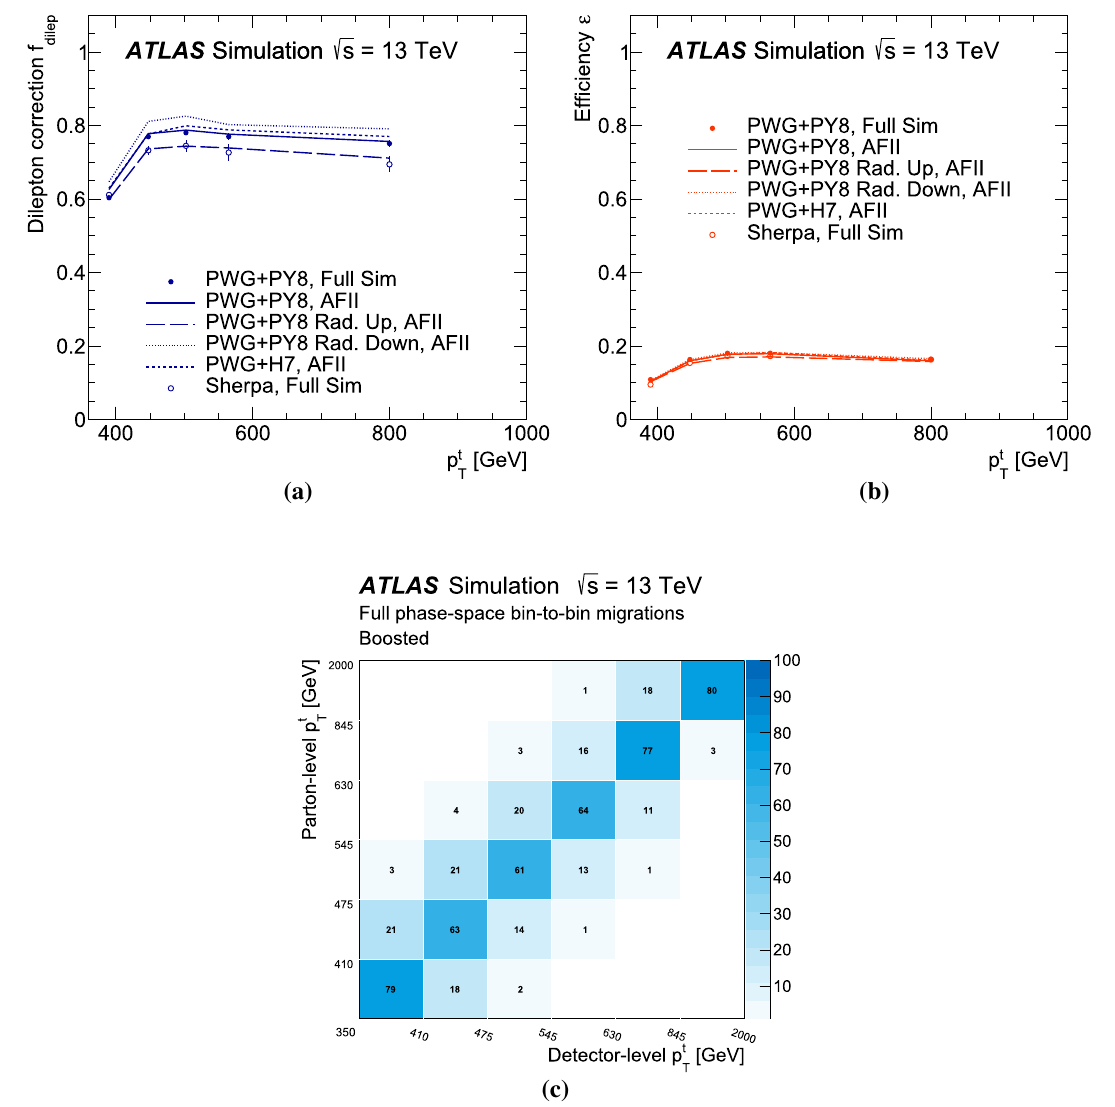
Fig. 16 The a dilepton f dilep and b efficiency ε corrections (evalu- ated with the Monte Carlo samples used to assess the signal modelling uncertainties, as described in Sect. 9.2), and c the migration matrix